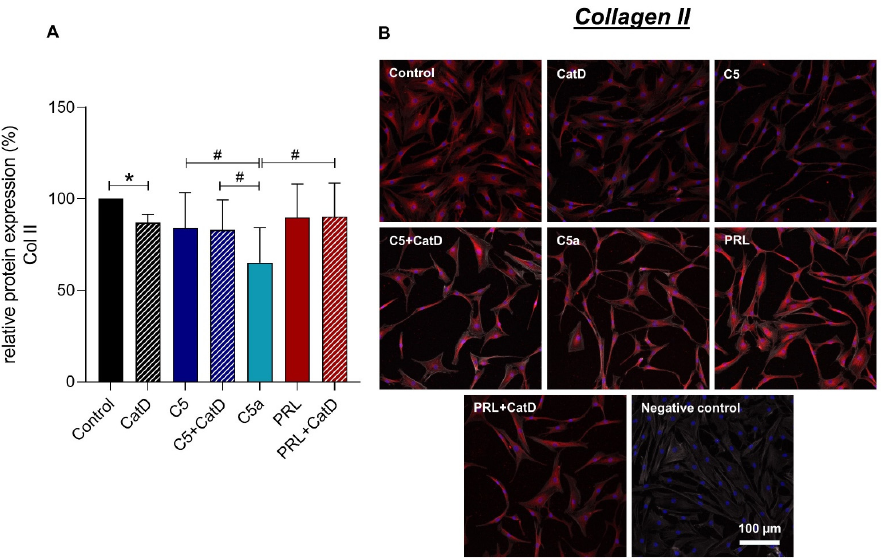
Figure 5. Chondrocytes protein expression of collagen type II after 72 h of stimulation and negative control of the staining. n = 3 independent experiments with chondrocytes from different donors. ( A ): Graphic representation of relative collagen type II protein fluorescence intensity, mean with standard deviation. Control has been normalized to 1. One sample t-test with significance in relation to control (*). Mixed-effects analysis using post-hoc Tukey’s multiple comparisons (#). */# = p ≤ 0.05. ( B ): representative images of chondrocytes immunolabeled with collagen type II specific antibodies. Red (Alexa Fluor 555) = collagen type II, blue (DAPI) = cell nuclei, grey (Phalloidin Alexa 633) = actin cytoskeleton. Scale bar = 100 µ